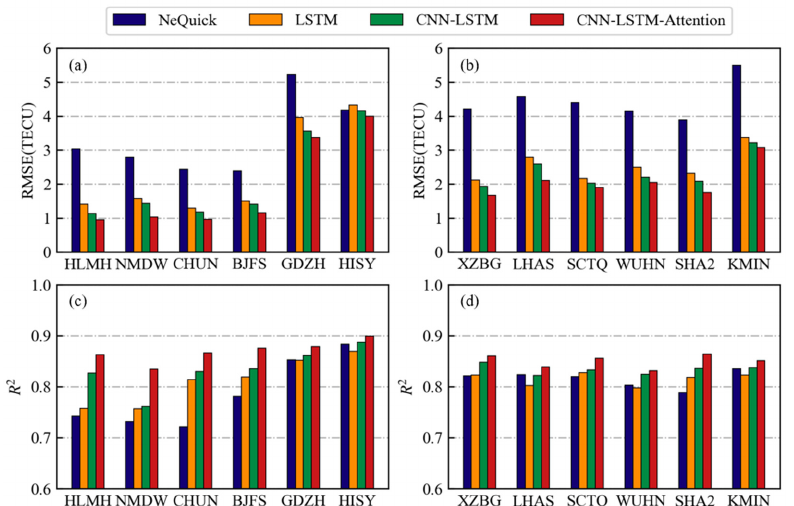
Table 3. The overall evaluation indexes of four models in 24 stations in the test set.